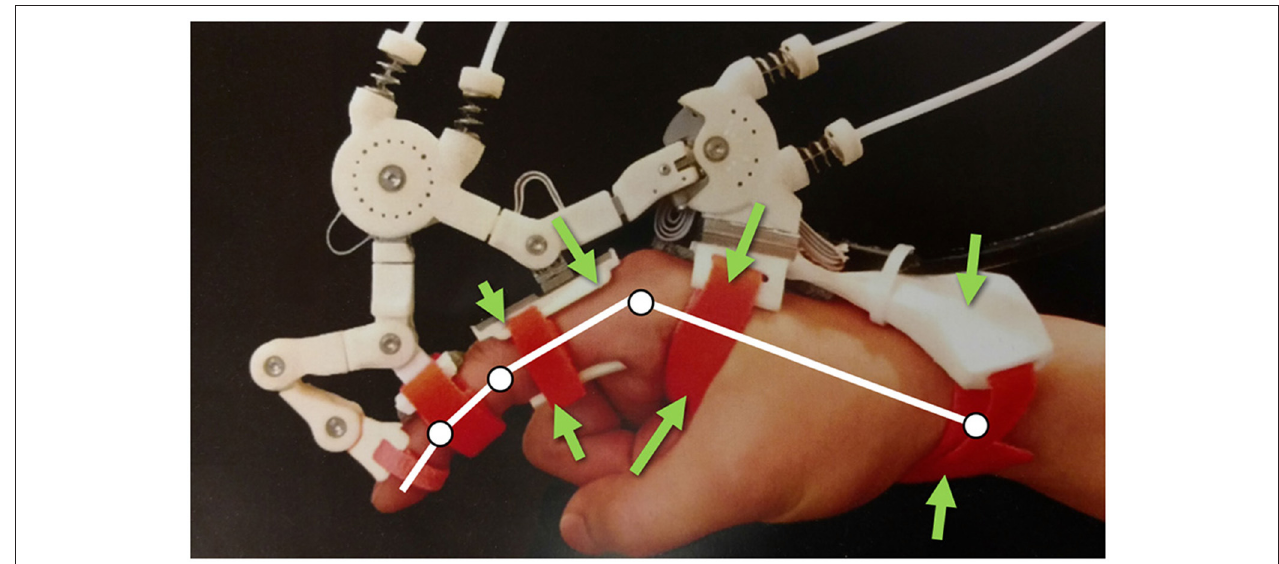
FIGURE 1 | Maestro Hand Exoskeleton from Agarwal et al. (2015), with force arrows indicating various locations of PHRII in this